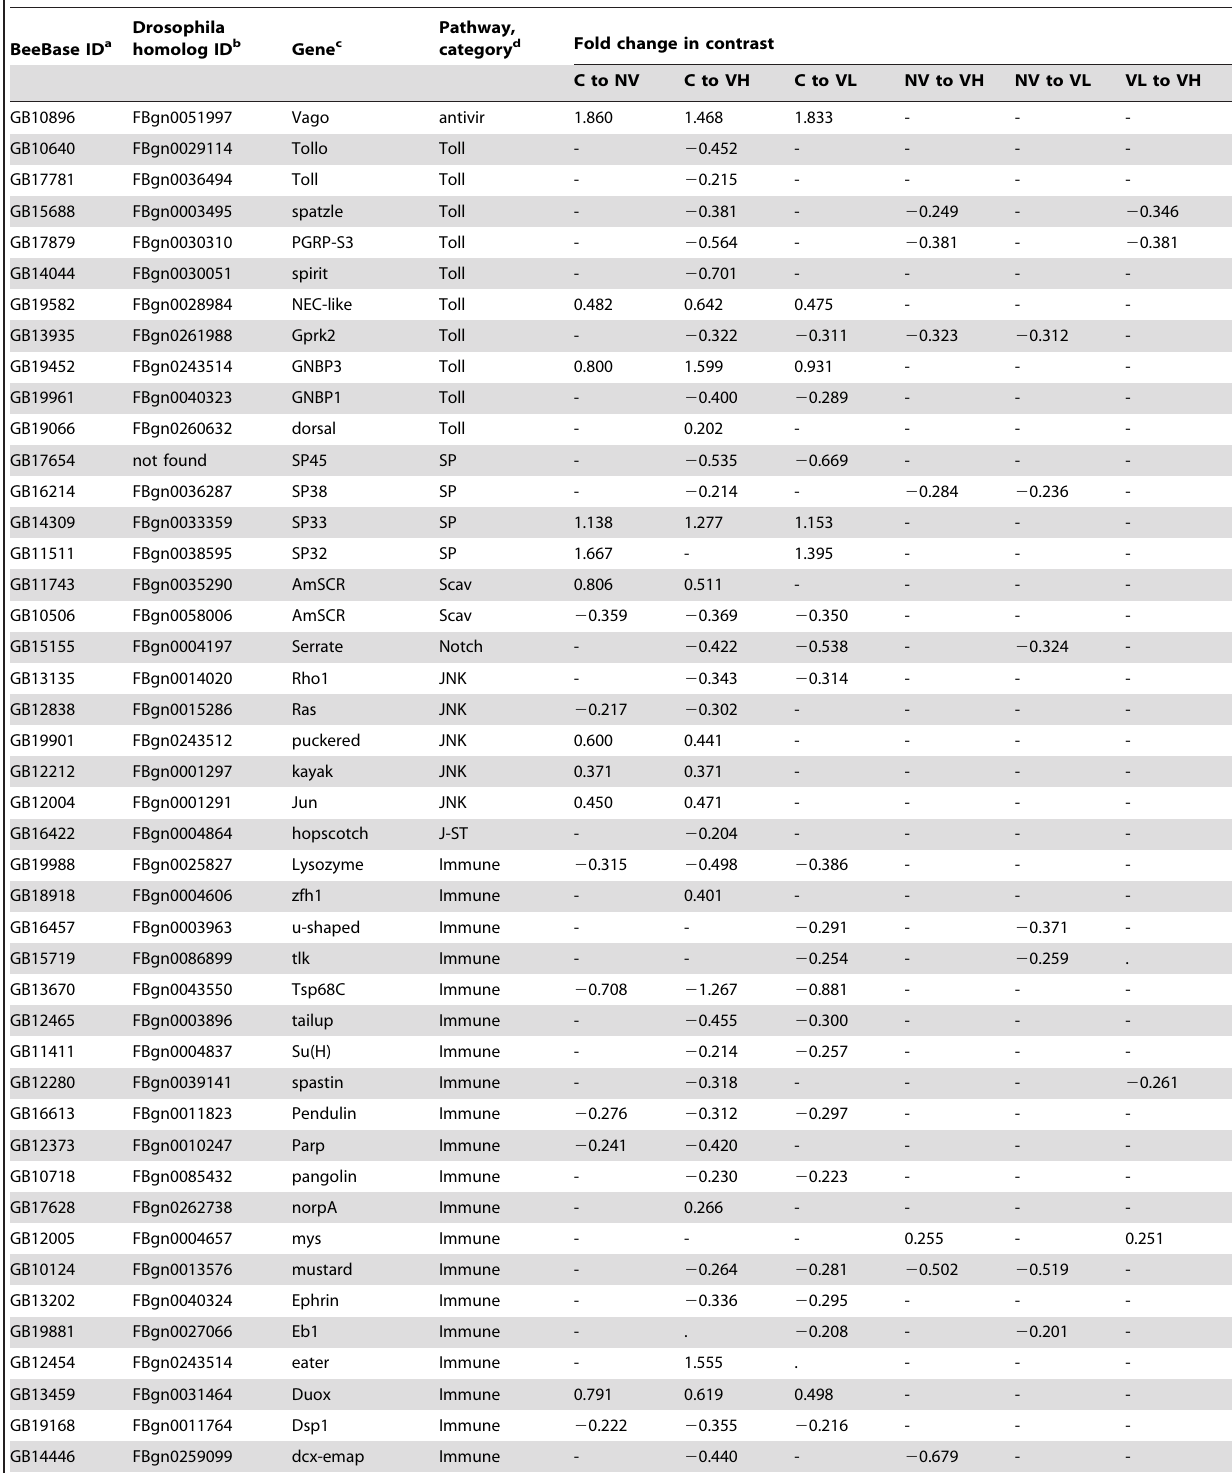
Table 1. Differential expression of the honeybee immune-related genes in response to oral DWV and Varroa mite feeding.